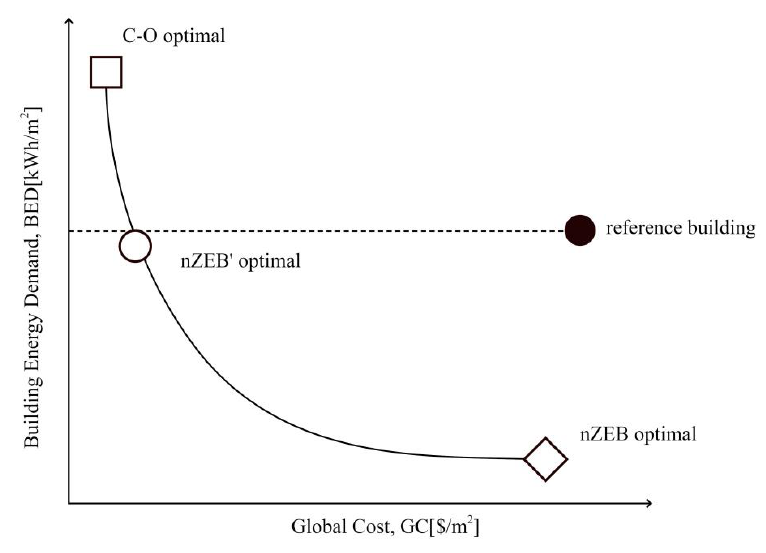
Figure 16. Relationship between nZEB, nZEB’, and C-O optimal solutions.